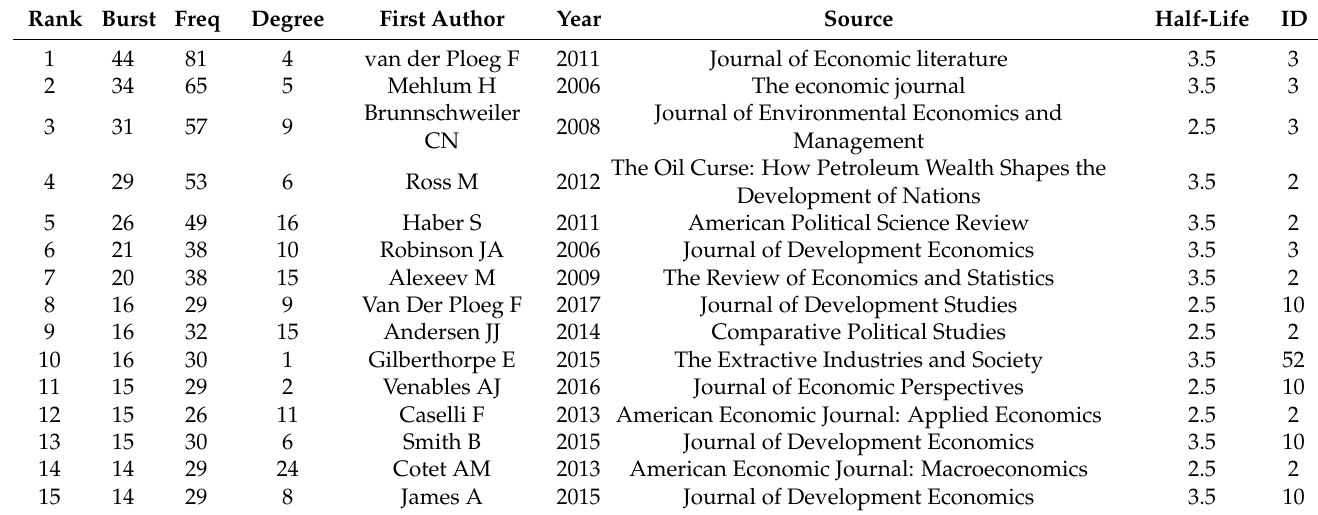
Table 11. Top 15 references of the most citation